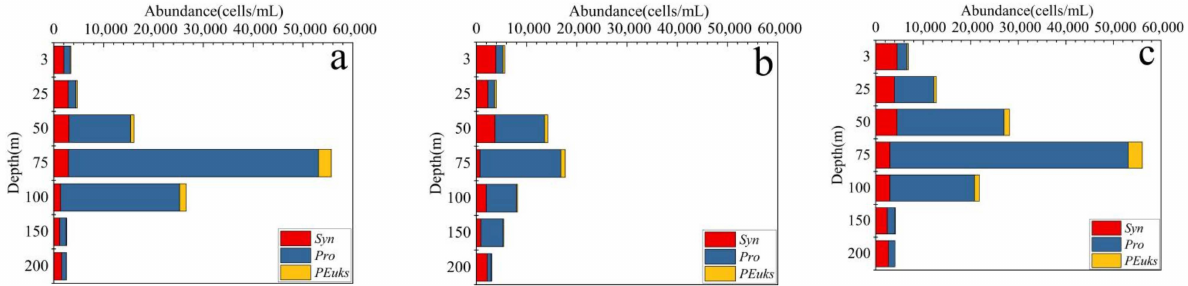
Figure 6. The vertical distribution of pico in three regions. ( a ) EQ, ( b ) BOB, and ( c ) EB. Bay of Bengal (BOB), the Equator (EQ), and the eastern border of the Indian Ocean near Sumatra (EB). Synechococcus ( Syn ), Prochlorococcus ( Pro ), Picoeukaryotes ( PEuks ).